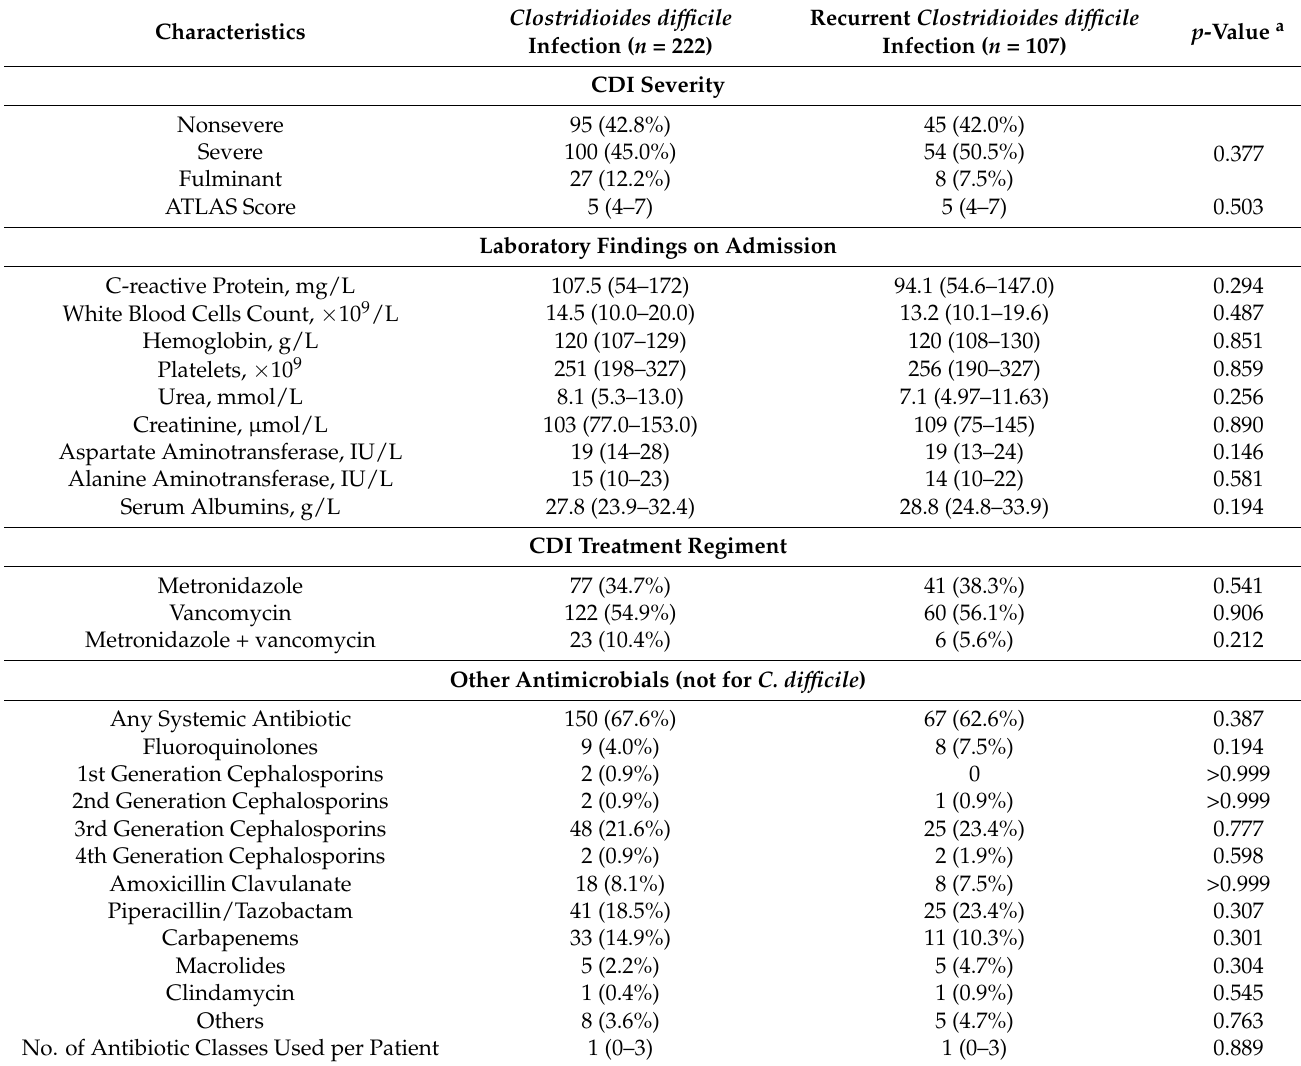
Table 2. Clinical, laboratory and treatment characteristics during the first episode of